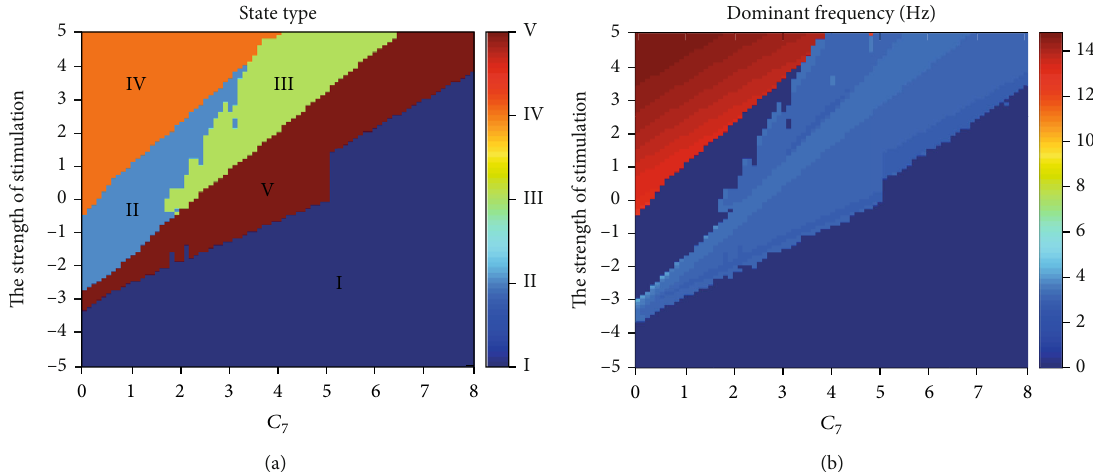
Figure 9: The state types (a) and dominant frequencies (b) after single-pulse stimulation acting on RE at t = 10 s when the system is in di ff erent initial states. Rich fi ring states such as I (high saturated state), II (low saturated state), III (SWD), IV (tonic), and V (low- frequency clonic) can be observed. The dominant frequencies of states I and II are 0Hz and of states III and V are between 2Hz and 4 Hz, while the dominant frequencies of state IV are nearly 14